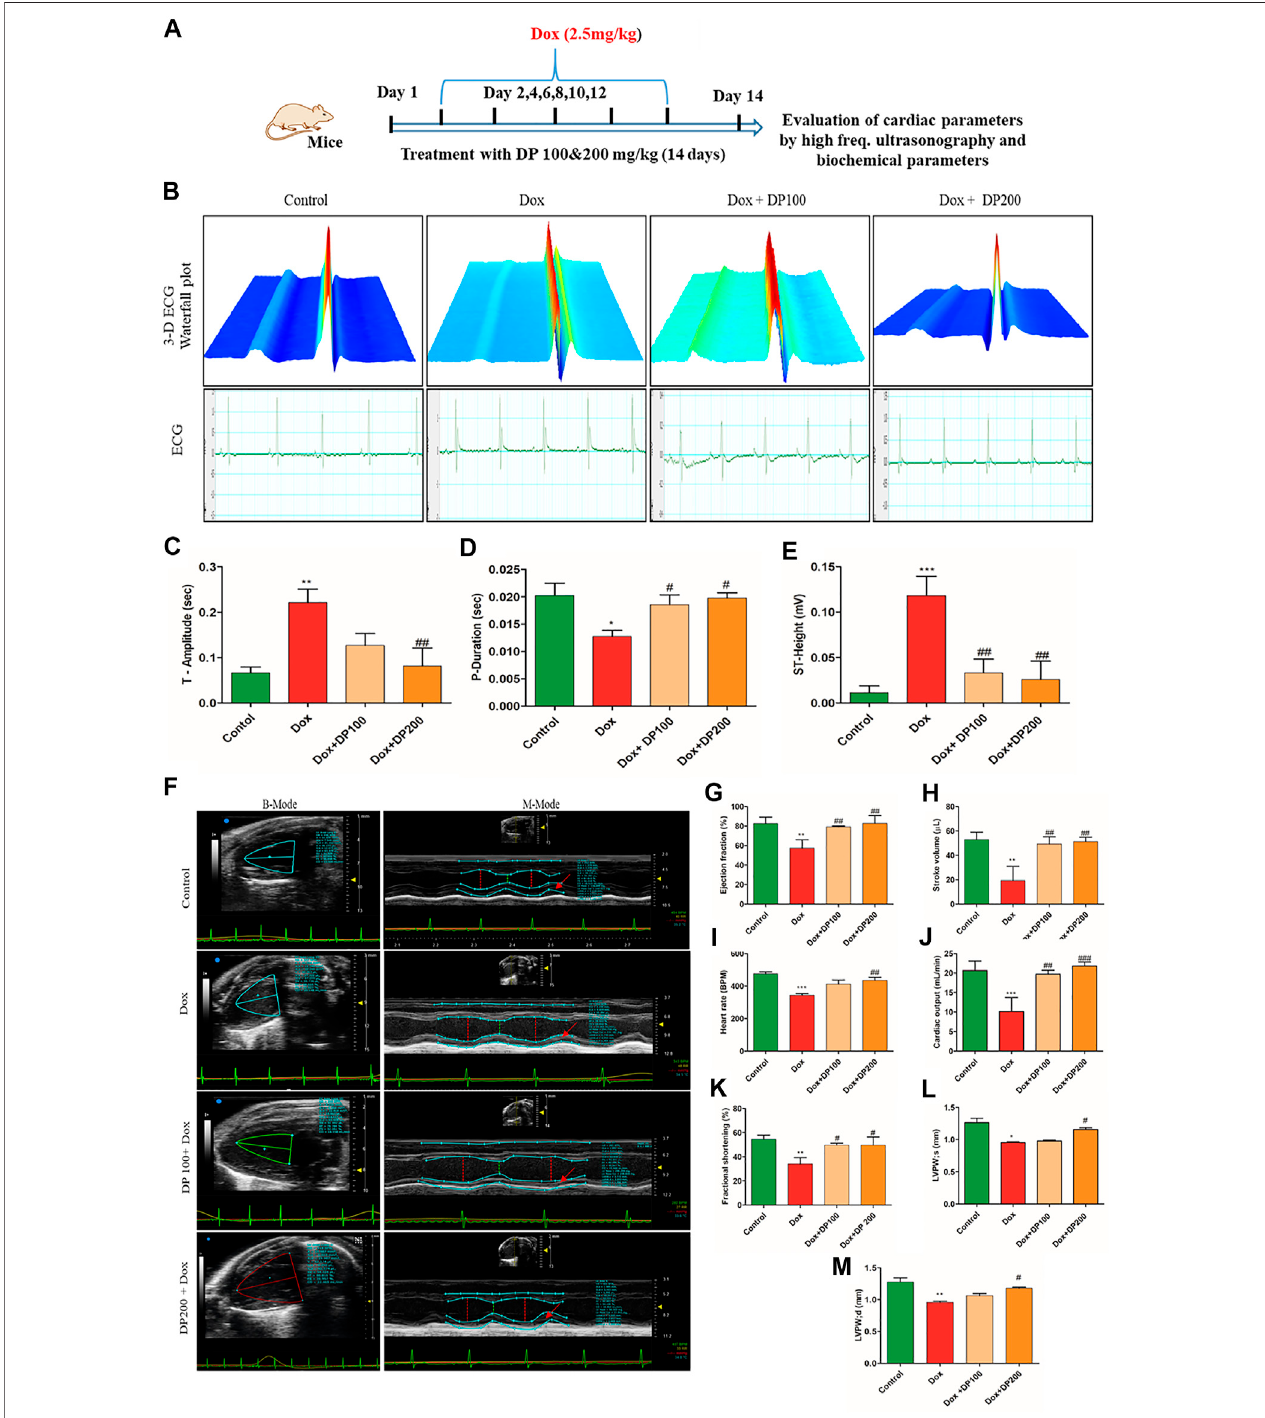
FIGURE 4 | Effect of DP extracts on the electrocardiogram. (A) Representative study design for cardioprotective model. (B) 3-D representative images of the electrocardiogram with elevated T-wave (I) Control (II) Dox control (III) Dox + DP100 and (IV) Dox + DP 200 (C) P-Duration (D) T- Amplitude (E) ST- Height, where n (cid:2) 5. EffectofDPextract on in-vivo cardiac parametersbyVevoLazer X3100. (F) Representative imagesofM-Mode(I)control(II) Doxcontrol(III) Dox+DP100and(IV) Dox+ DP200. (G) Ejection fraction. (H) Stroke volume. (I) Heart rate. (J) Cardiac output (K) Fractional shortening (L) left ventricular posterior wall thickness (systole) (M) left ventricular posterior wall thickness (diastole), where n (cid:2) 4. The data were analyzed by One Way ANOVA using Graph Pad Prism. *** p < 0.001, ** p < 0.01, * p < 0.05 represents normal control vs disease control (Dox). # p < 0.05 ## p < 0.01 and ### p < 0.001 represents disease control (Dox) vs treatment groups.